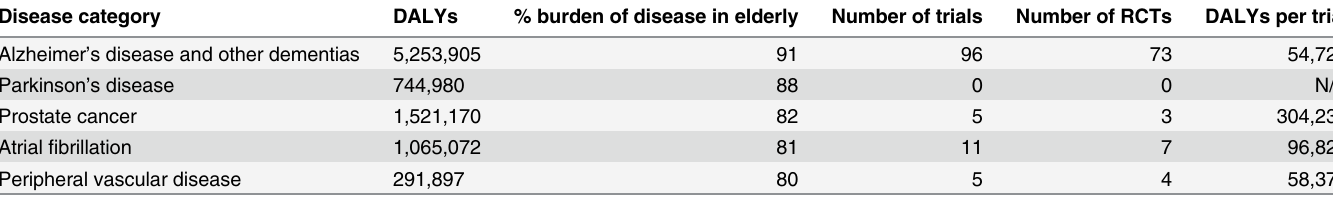
Table 4. Trials studying disease categories with (cid:1) 80% of disease burden among elderly persons. Disease category DALYs % burden of disease in elderly Number of trials Number of RCTs DALYs per trial Alzheimer ’ s disease and other dementias 54,728 Parkinson ’ s disease 744,980 88 0 N/A Prostate cancer 1,521,170 Atrial fi brillation Peripheral vascular